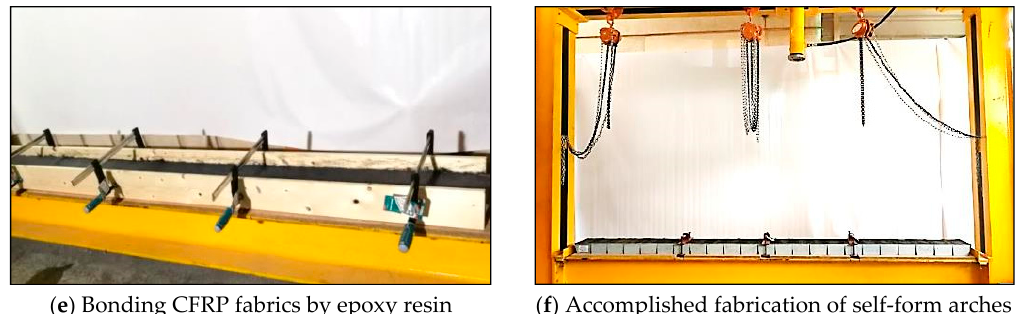
Figure 5. Fabrication of self-form segmental concrete masonry arches.